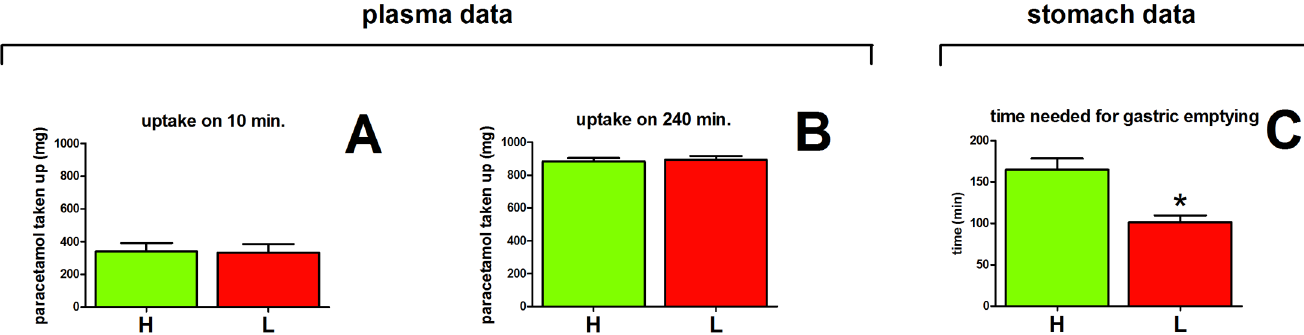
Fig 4. Discrepancy in gastric emptying deduced from the paracetamol plasma data and deduced form content in the stomach, show no difference in gastric emptying between the high and low caloric meals. The amount of paracetamol taken up after 10 min (panel A) and 240 min (panel B) calculated form the concentration time curve of paracetamol in plasma do not show a difference between the high and low caloric meals. However, the time needed for gastric emptying determinded by the paracetamol content of the stomac (panel C), show a clear difference in gastric emptying between the high and low caloric meals. * different form the low caloric value (P < 0.05)